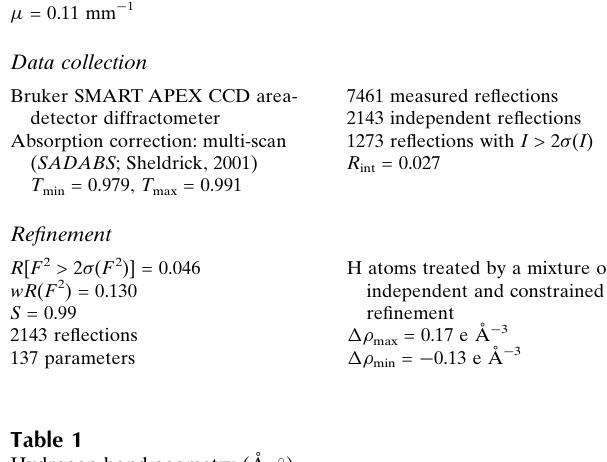
Hydrogen-bond geometry (A˚ , (cid:3)